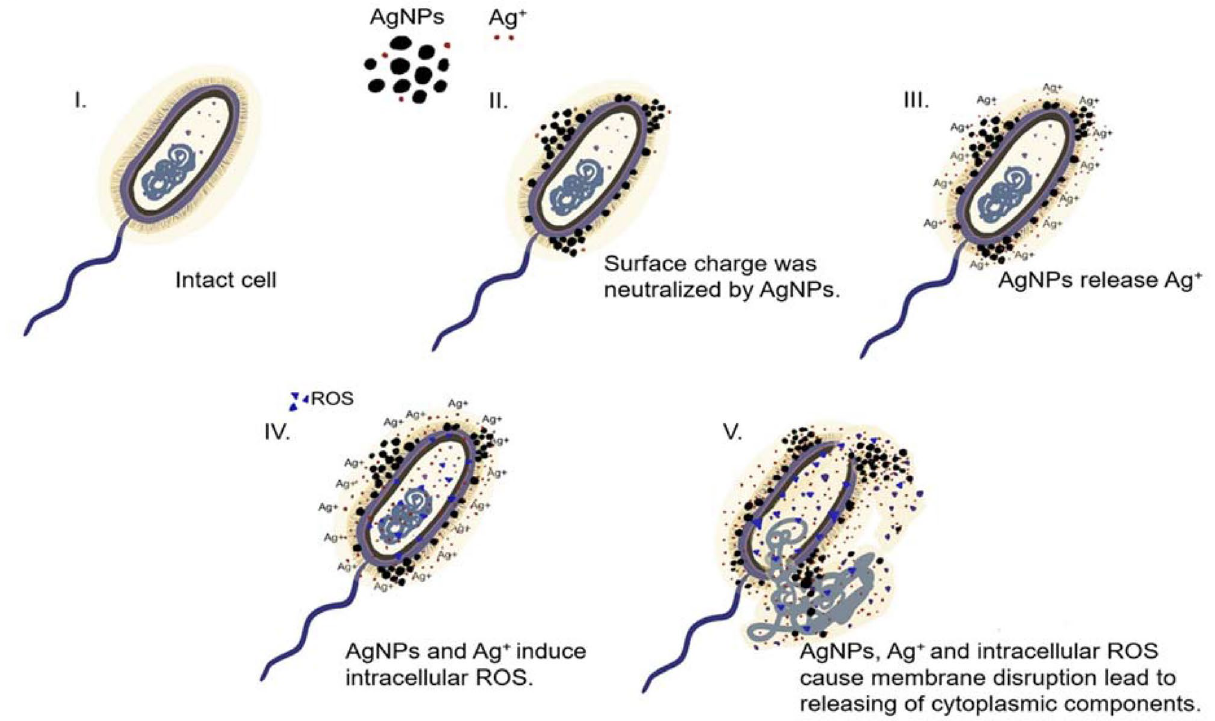
Figure 8. The proposed mode of action of andro-AgNPs against B. pseudomallei . ( I. ) Untreated bacterial cell with a smooth and intact surface. ( II. ) Once andro-AgNPs are added, bacterial cell surface charge is neutralized due to AgNP binding. ( III. ) After binding of AgNPs to cell surface, Ag + is released in large fraction locally. ( IV. ) AgNPs and Ag + induce intracellular ROS that promotes biomolecule (protein, DNA, lipid etc.) damage and a disrupted bacterial membrane. ( V. ) Eventually, bacterial cell death occurs by the combined action of AgNPs, Ag + and generation of intracellular ROS. This figure was drawn by Saengrawee